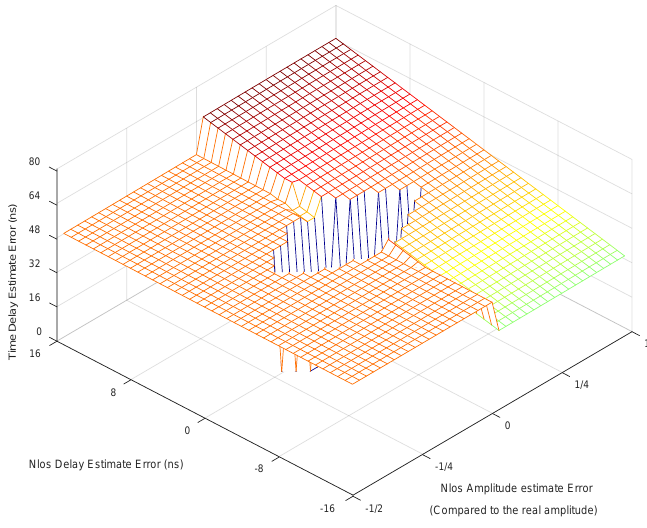
Figure 11. The impact of estimation error of delay and amplitude of NLOS signal.